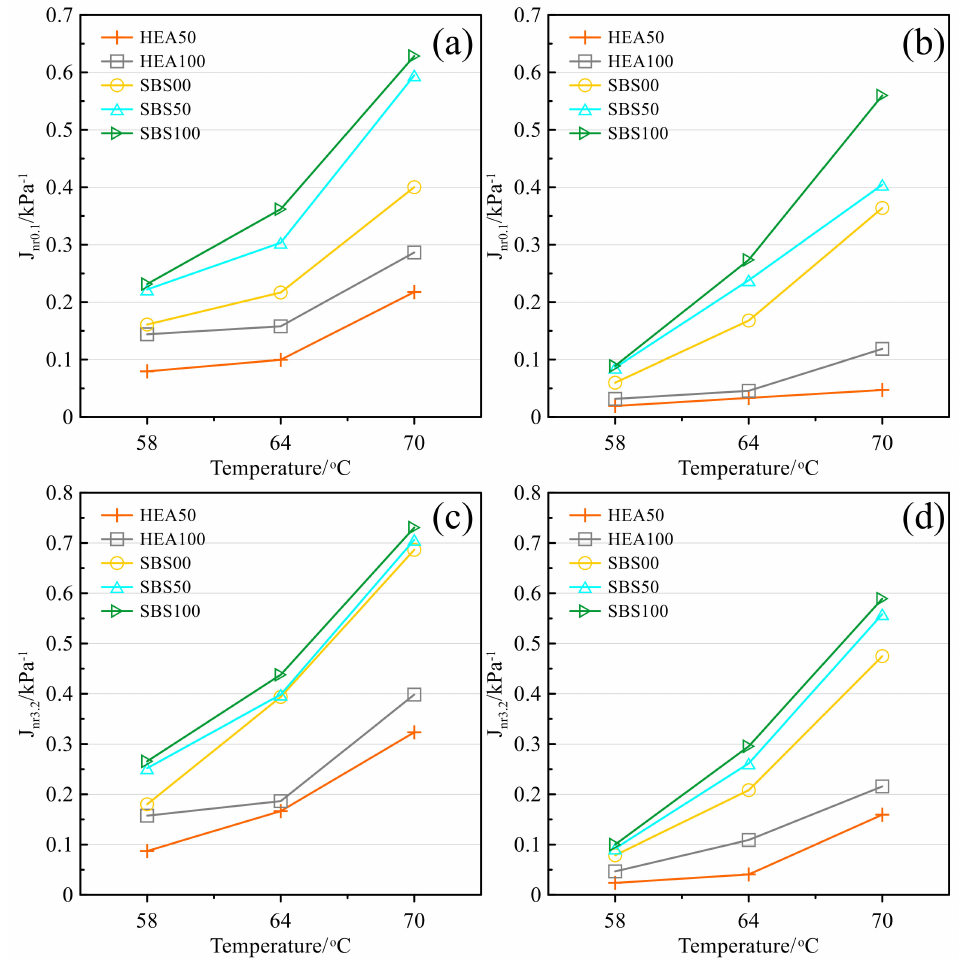
Figure 10. Creep compliance: ( a ) 0.1 kPa before TFOT; ( b ) 0.1 kPa after TFOT; ( c ) 3.2 kPa before TFOT; ( d ) 3.2 kPa after